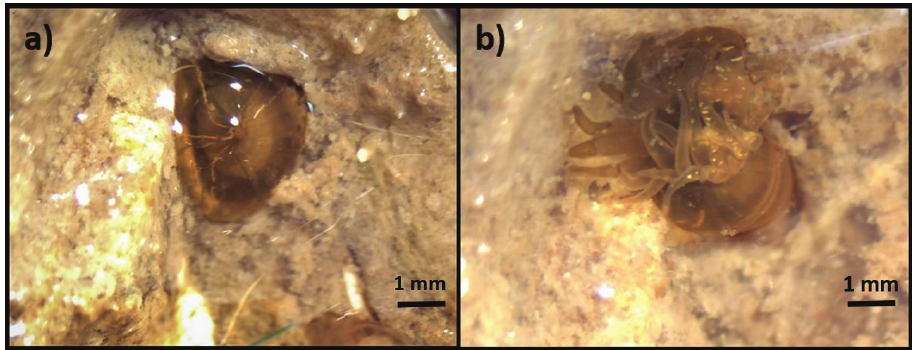
Figure 1. Diadumene lineata at Sportsman Road on Galveston Island with tentacles fully retracted ( a ), and with tentacles extended ( b